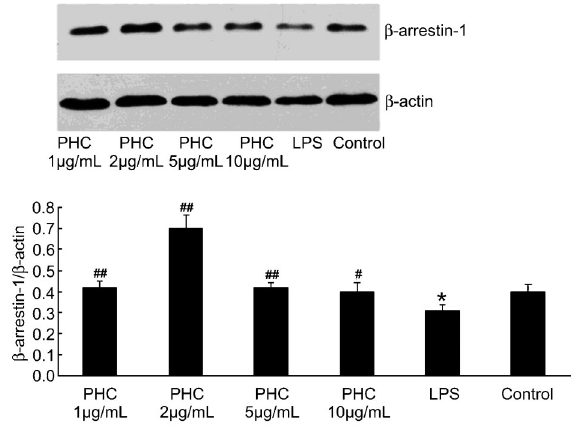
Figure 4. Effect of different concentrations of penehyclidine hydrochloride (PHC) on b -arrestin-1 expression in lipopolysac- charide (LPS)-induced human pulmonary microvascular endothe- lial cells (HPMEC) (n=3). HPMEC were pretreated with different concentrations of PHC (1, 2, 5, and 10 m g/mL) for 1 h and stimulated with 0.1 m g/mL LPS for another 24 h. Equal amounts of protein in the cell lysates were electrophoresed and the levels of protein were determined using specific antibodies. PHC at a concentration of 2 m g/mL upregulated expression of b -arrestin-1 most significantly. *P , 0.01, compared with control group; # P , 0.05, ## P , 0.01, compared with LPS group